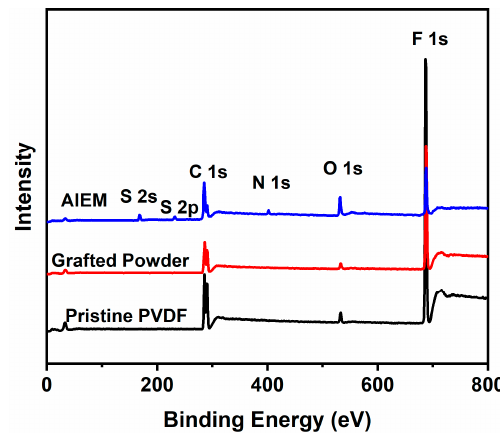
Figure 6. X-ray photoelectron spectroscopy (XPS) wide-scan spectra of pristine PVDF, grafted powder, and AIEM (GY = 28.4%).